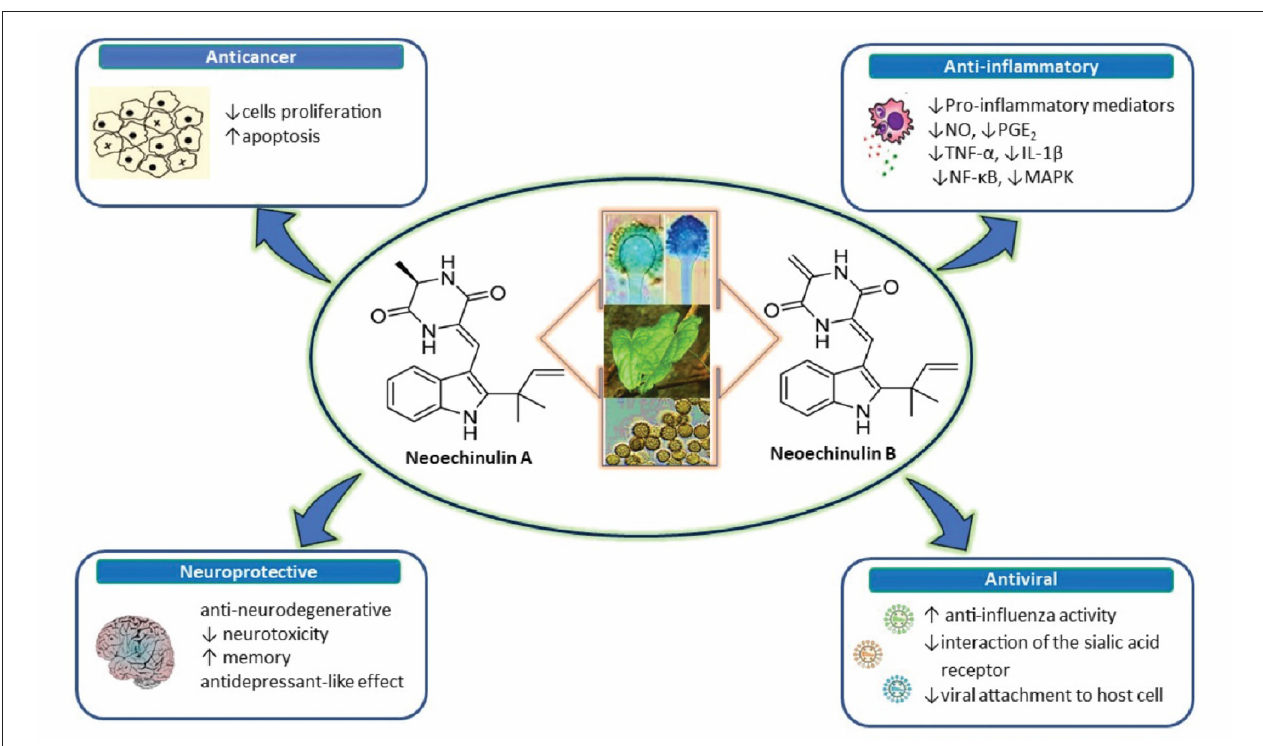
FIGURE 1 | A diagram with the relevant pharmacological properties of the most important neoechinulins and their potential mechanism of actions. NO, nitric oxide; PGE, prostaglandin E2; TNF- α , tumour necrosis alfa; IL-1 β , interleukin-1 β ; NF-K β , Nuclear factor- κβ ; MAPK, mitogen-activated protein